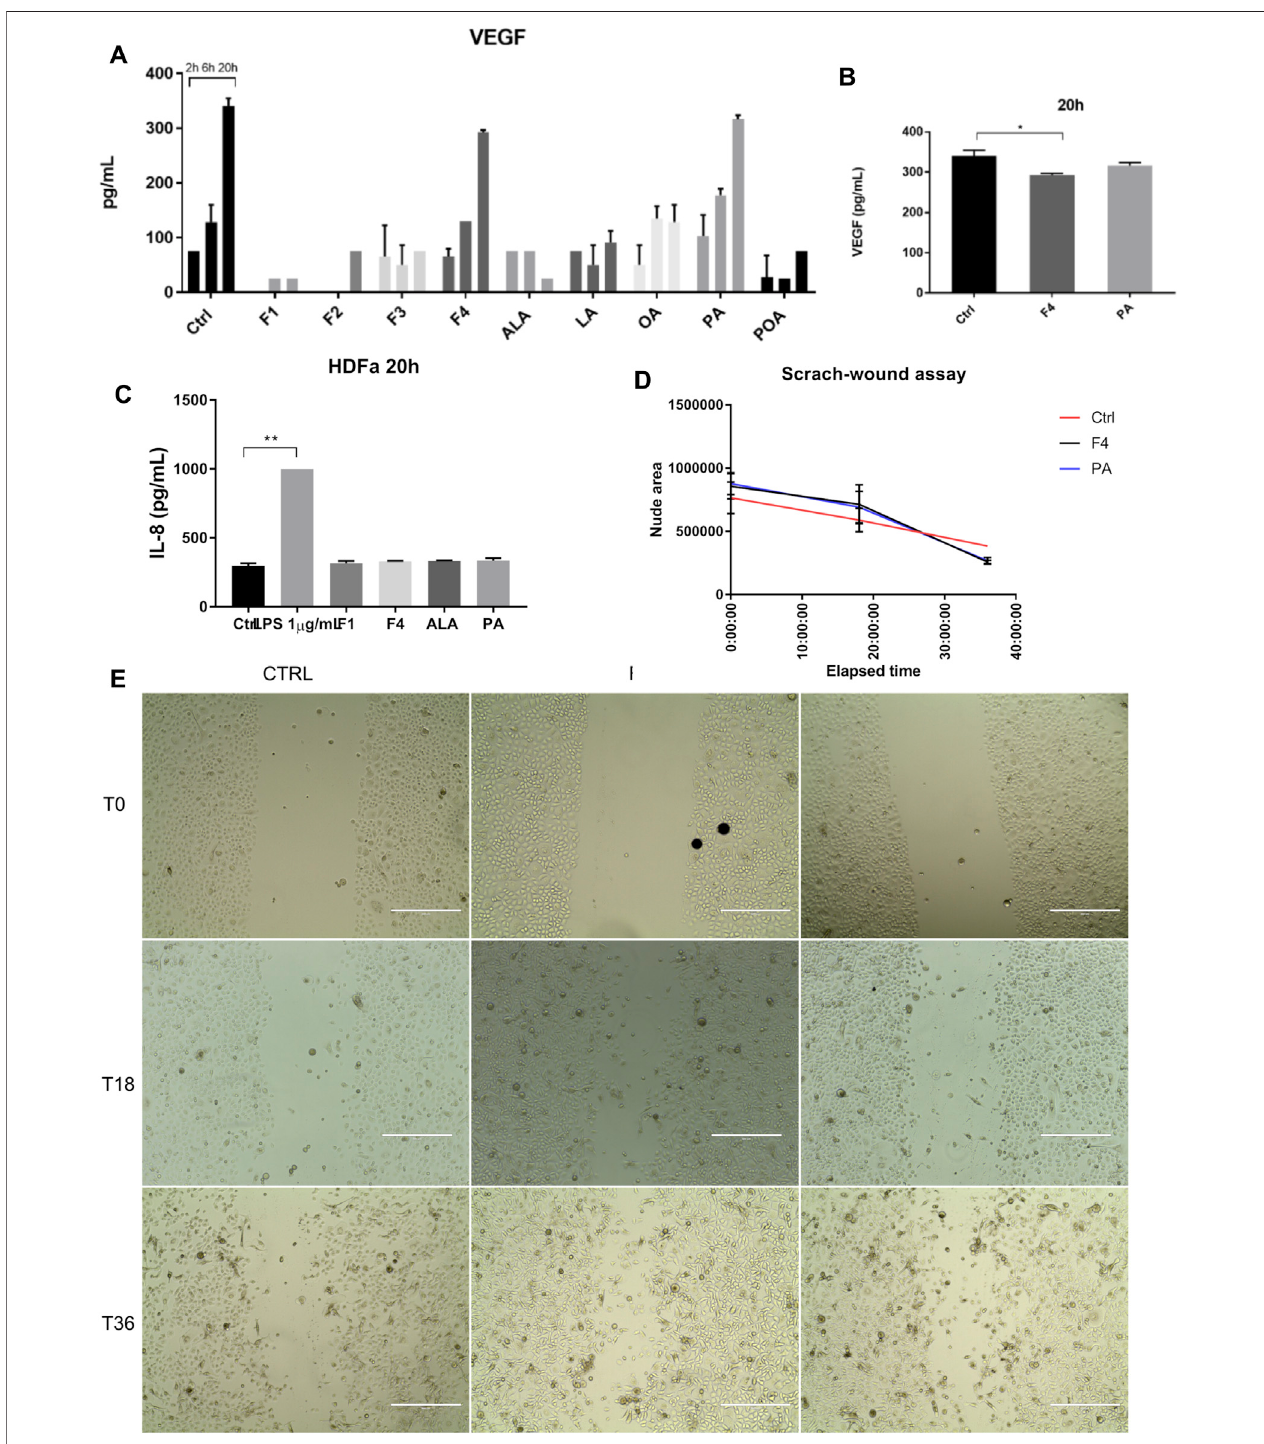
FIGURE4| Investigation ofselectedpuri fi edfraction effect onhumannormal fi broblasts. VEGFexpression showedasimilar trendinF4and PAtreatedcells,when assessed by multiplexing (A) and con fi rmed by ELISA (B) . IL-8 expression was not altered by cell treatment, as shown by ELISA analysis (C) . LPS was used as positive controlofin fl ammation. Bars represent the average ofduplicates ± S.D.,and each treatment wasassessed at three different time points 2, 6,20 h (* p < 0.05, ** p < 0.01, **** p < 0.0001, One-way ANOVA, Dunnett ’ s multiple comparison). Cell migration was stimulated after 20 h (D) , as assessed by scratch-wound assay (E) . Phase- contrast, 10x. Scale bar 400